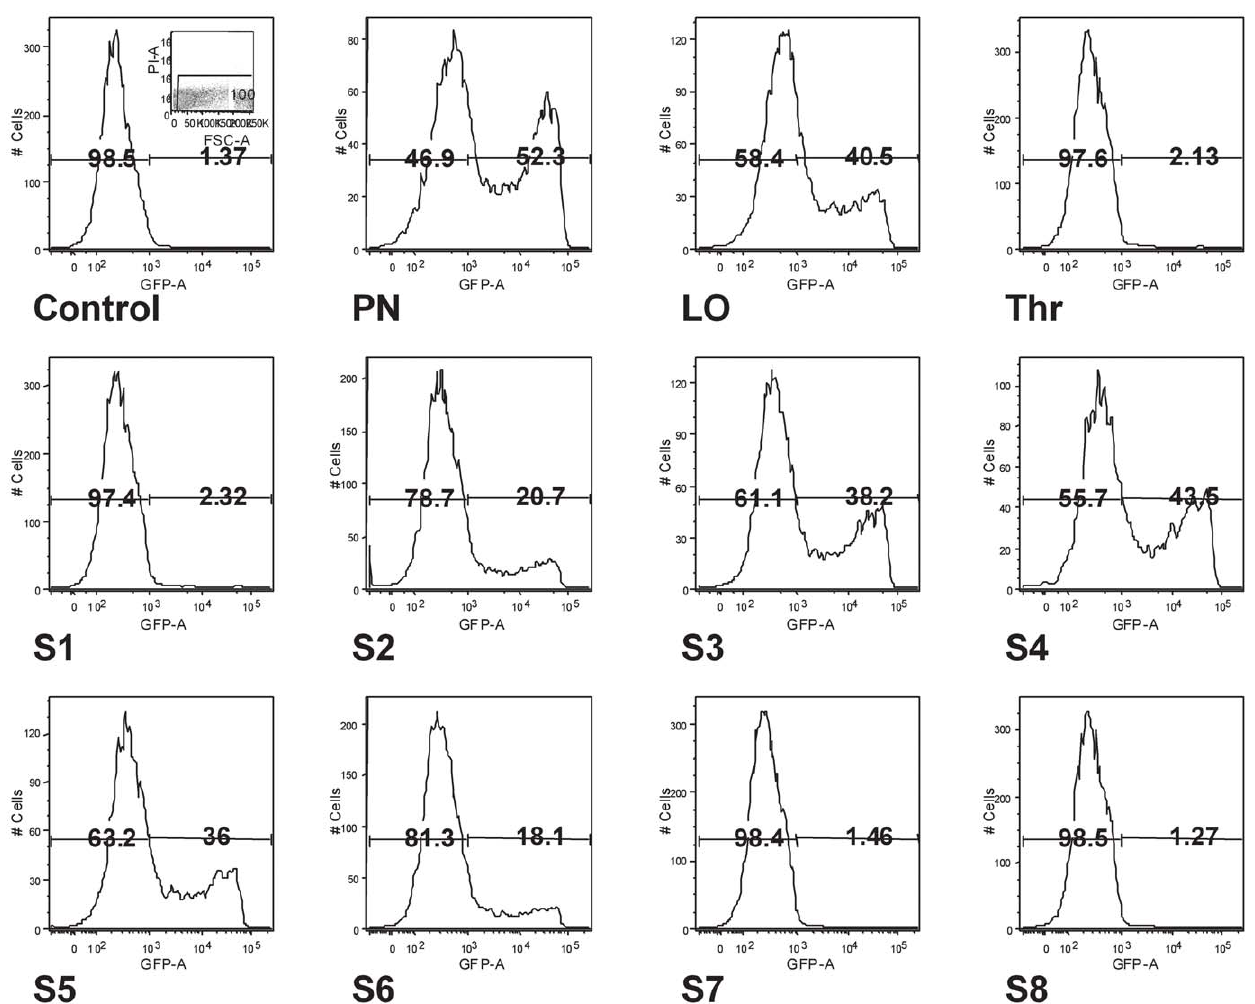
Figure 4. Transfection efficiencies mediated by RTNs carrying pEGFP plasmid and assessed by flow cytometry. RTNs were formed using pEGFP-N1 plasmid DNA. Aliquots of nanocomplexes nebulised through the NGI (as in Figure 2A and 3) were used to perform transfections. After 48 h incubation, cells were harvested and analysed by flow cytometry to determine the level of expression of enhanced green fluorescent protein (EGFP) in the samples collected from each NGI stage. A representative experiment carried out in normal human bronchial epithelial cell-line 16HBE14o- is shown (cumulative experiments are summarised in Table 2). The dot-plot profile of untransfected cells (ctrl) represents the population selected as alive whereas the 1st panel of histogram profile shows where the markers to discriminate the EGFP positive from negative population were set. On each panel the percentage of EGFP negative (left) and EGFP positive (right) cells is indicated. PN=represent cells transfected with pre- nebulisation RTN suspension; LO=cells treated with leftover nanocomplexes in the nebuliser chamber after nebulisation, Thr=throat, and S1–S8 cells transfected with samples from the different NGI stages, respectively.